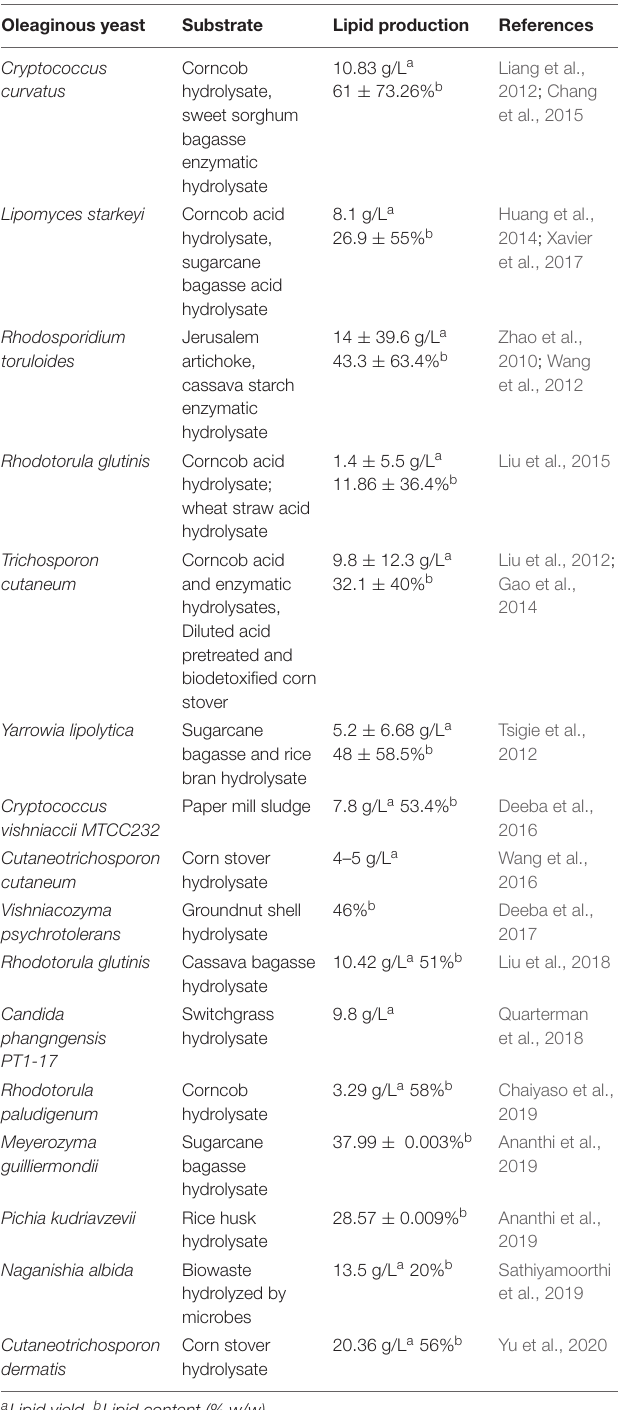
TABLE 3 | Lipid production by oleaginous yeast using lignocellulose